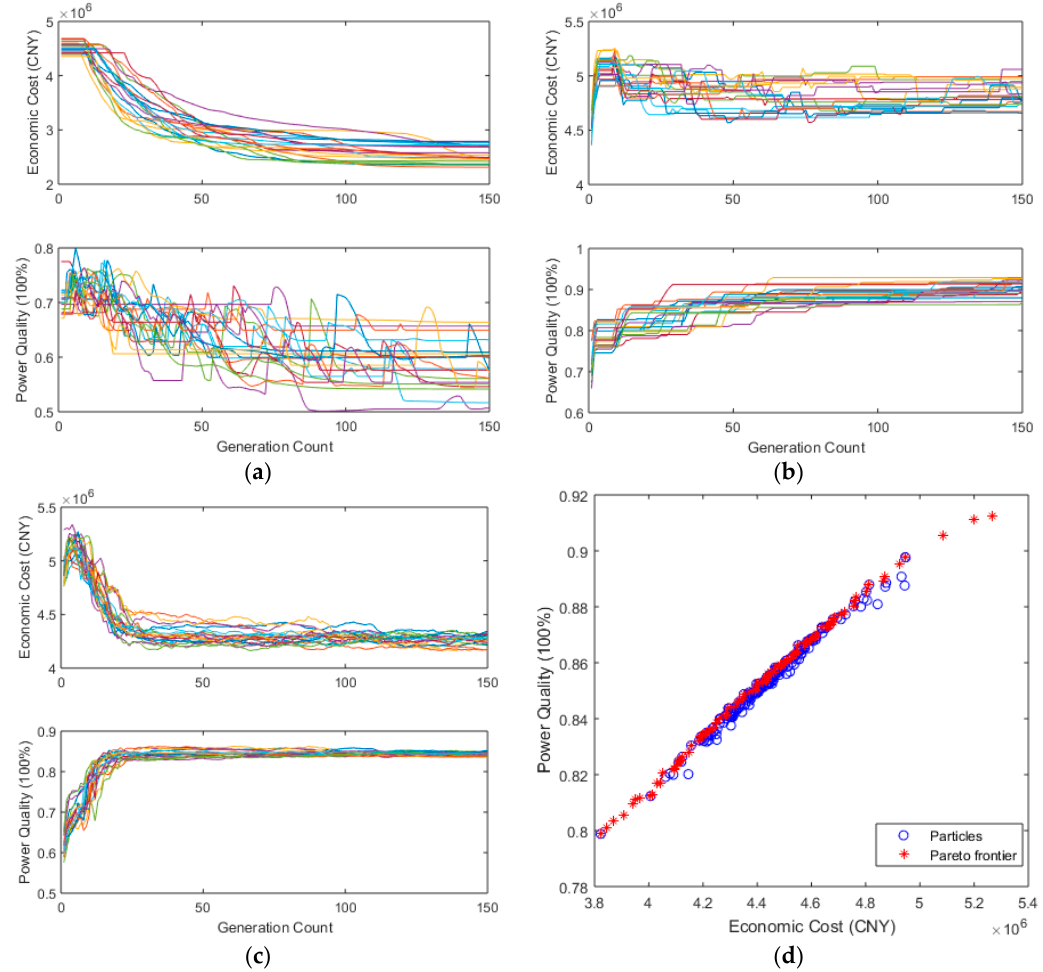
Figure 12. Optimization results of mono-objective and bi-objective: ( a ) “money-oriented” scenario; ( b ) “user-first” scenario; ( c ) “Pareto-optimal” scenario; ( d ) economic cost and power quality (EC-PQ) plane after 150 generations.